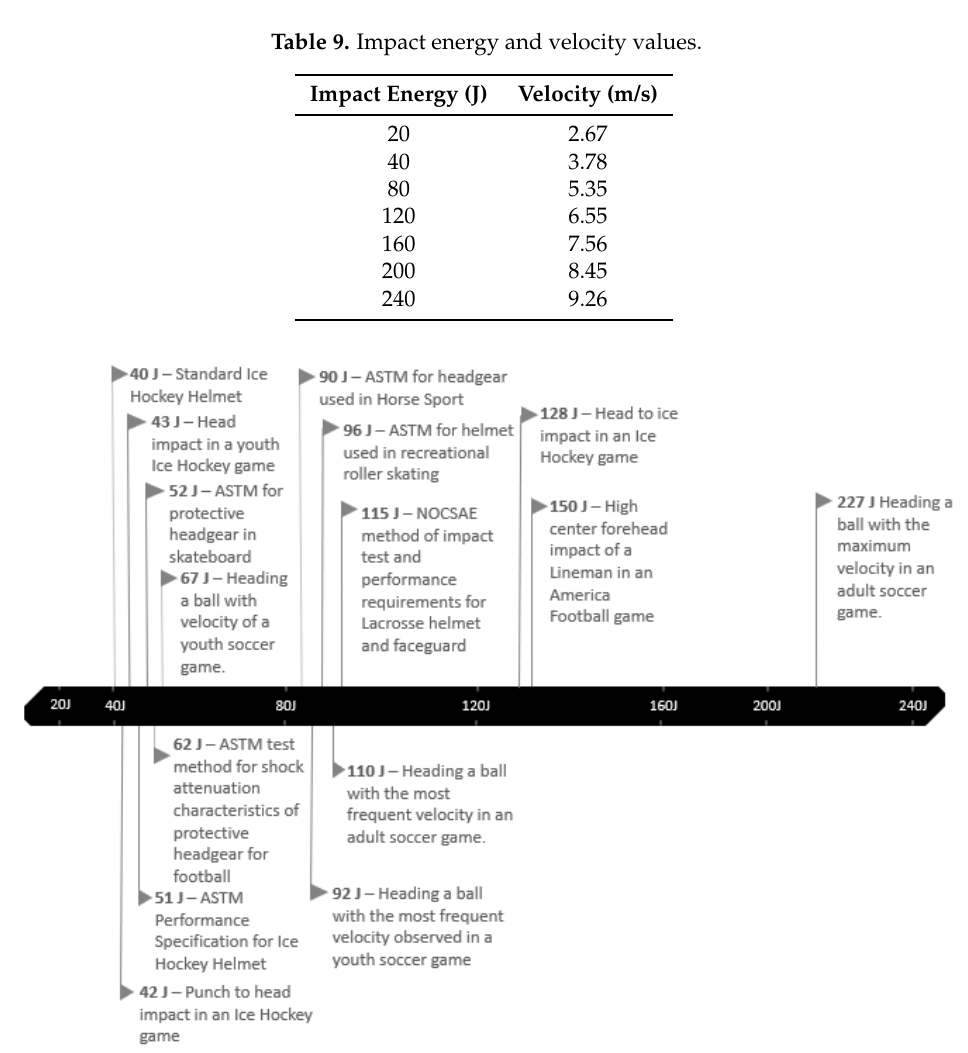
Figure 8. Impact energy in different situations